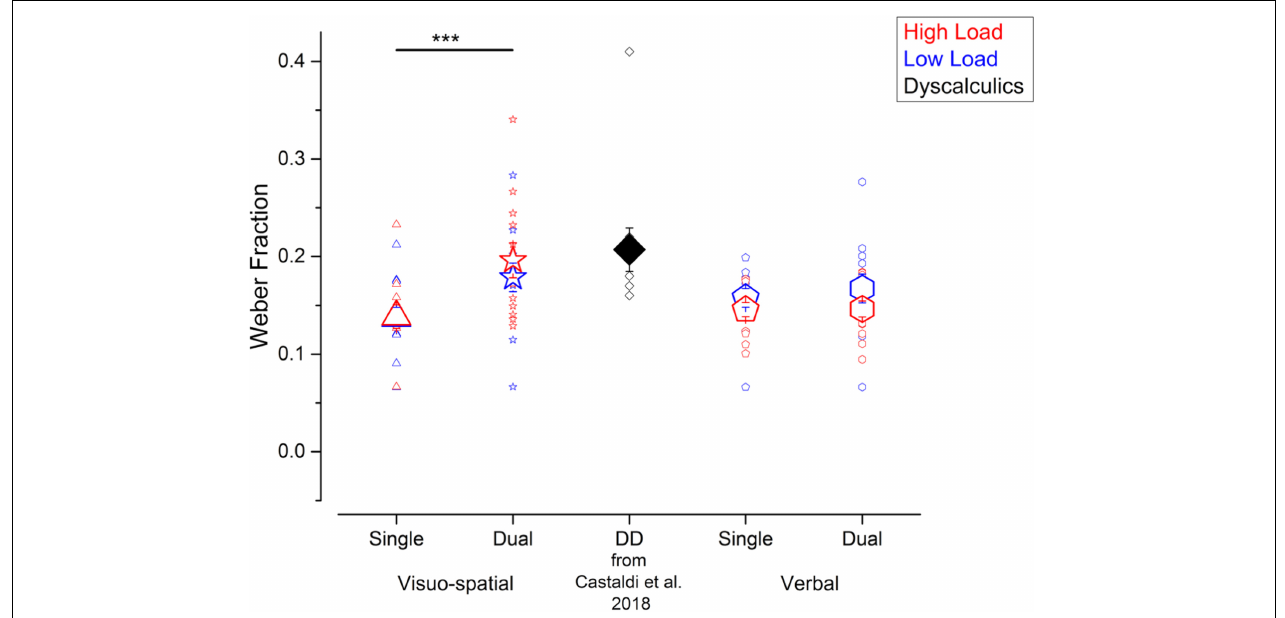
FIGURE 2 | Participants’ precision in the numerosity discrimination tasks. Wfs measured in the different experiments performed in the current study (blue and red symbols) and for the DD participants tested in Castaldi et al. (2018) (black symbols, for qualitative comparison). Blue and red symbols identify the Wfs measured when fewer or more elements were presented before and after the arrays of dots (corresponding to the low and high load conditions in the working memory task). Large and small symbols indicate the average ± SEM and individual Wfs, respectively. *** p < 0.005.